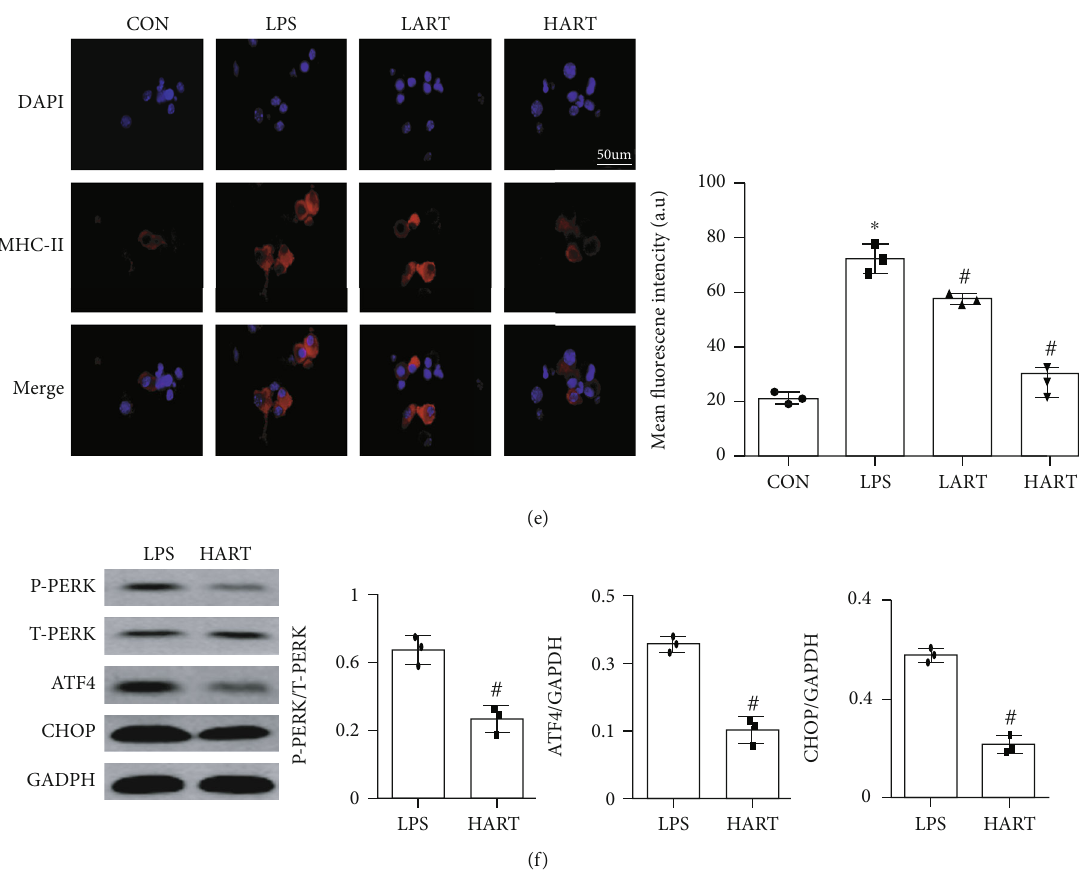
Figure 5: (a) Flow cytometric sorting of CD11c+ and CD86+ cells in lymph nodes; (b) fl ow cytometric sorting of CD11c+ and MHC-II+ cells in lymph nodes ( ∗ P < 0 : 05 compared with NC; # P < 0 : 05 compared with HT); (c) fl ow cytometric sorting of CD11c+ and CD86+ cells in BMDCs; (d) fl ow cytometric sorting of CD11c+ and MHC-II+ cells in BMDCs ( ∗ P < 0 : 05 compared with CON; # P < 0 : 05 compared with LPS); (e) immuno fl uorescence staining and mean fl uorescence intensity of MHC-II in BMDCs (blue: DAPI, red: MHC-II); (f) western blotting of PERK/ATF4/CHOP signaling pathway ( # P < 0 : 05 compared with